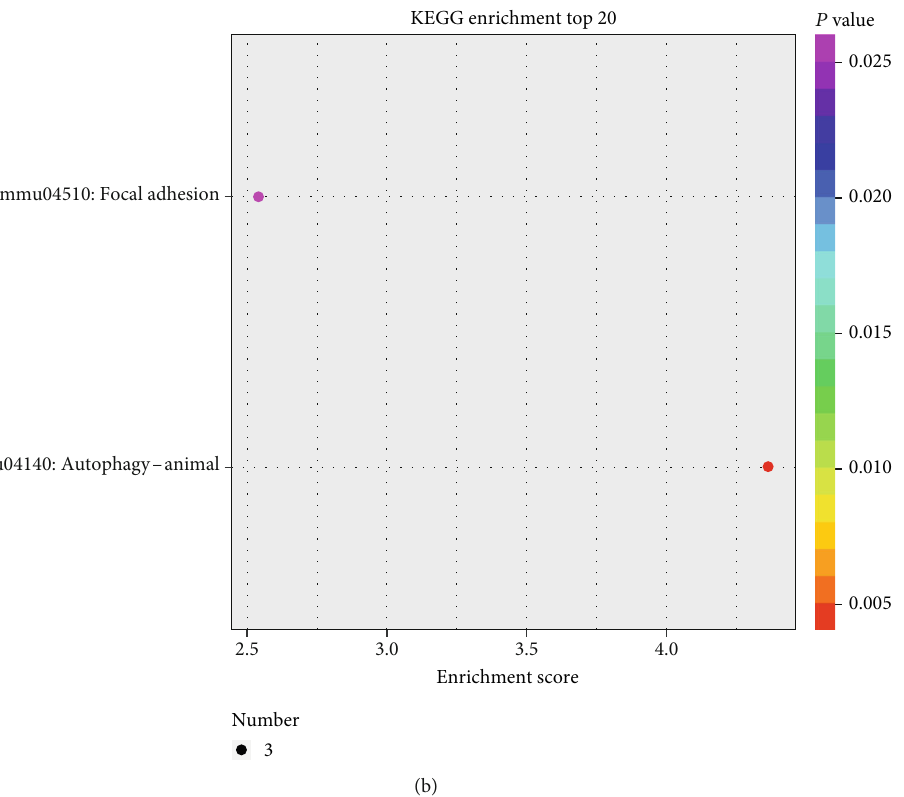
Figure 8: Di ff erential cirRNA functional annotation and pathway analysis between undi ff erentiated and di ff erentiated MSCs. (a) GO analysis. (b) KEGG analysis.